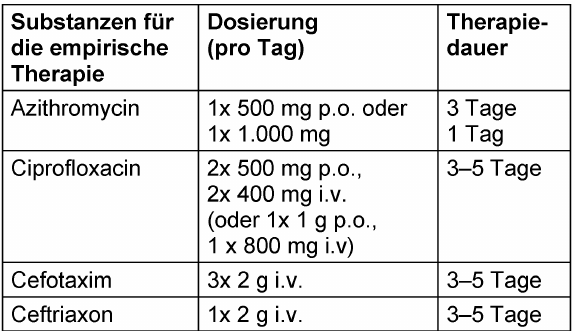
Tabelle 3: Empfehlung für die kalkulierte Therapie bakterieller gastrointestinaler